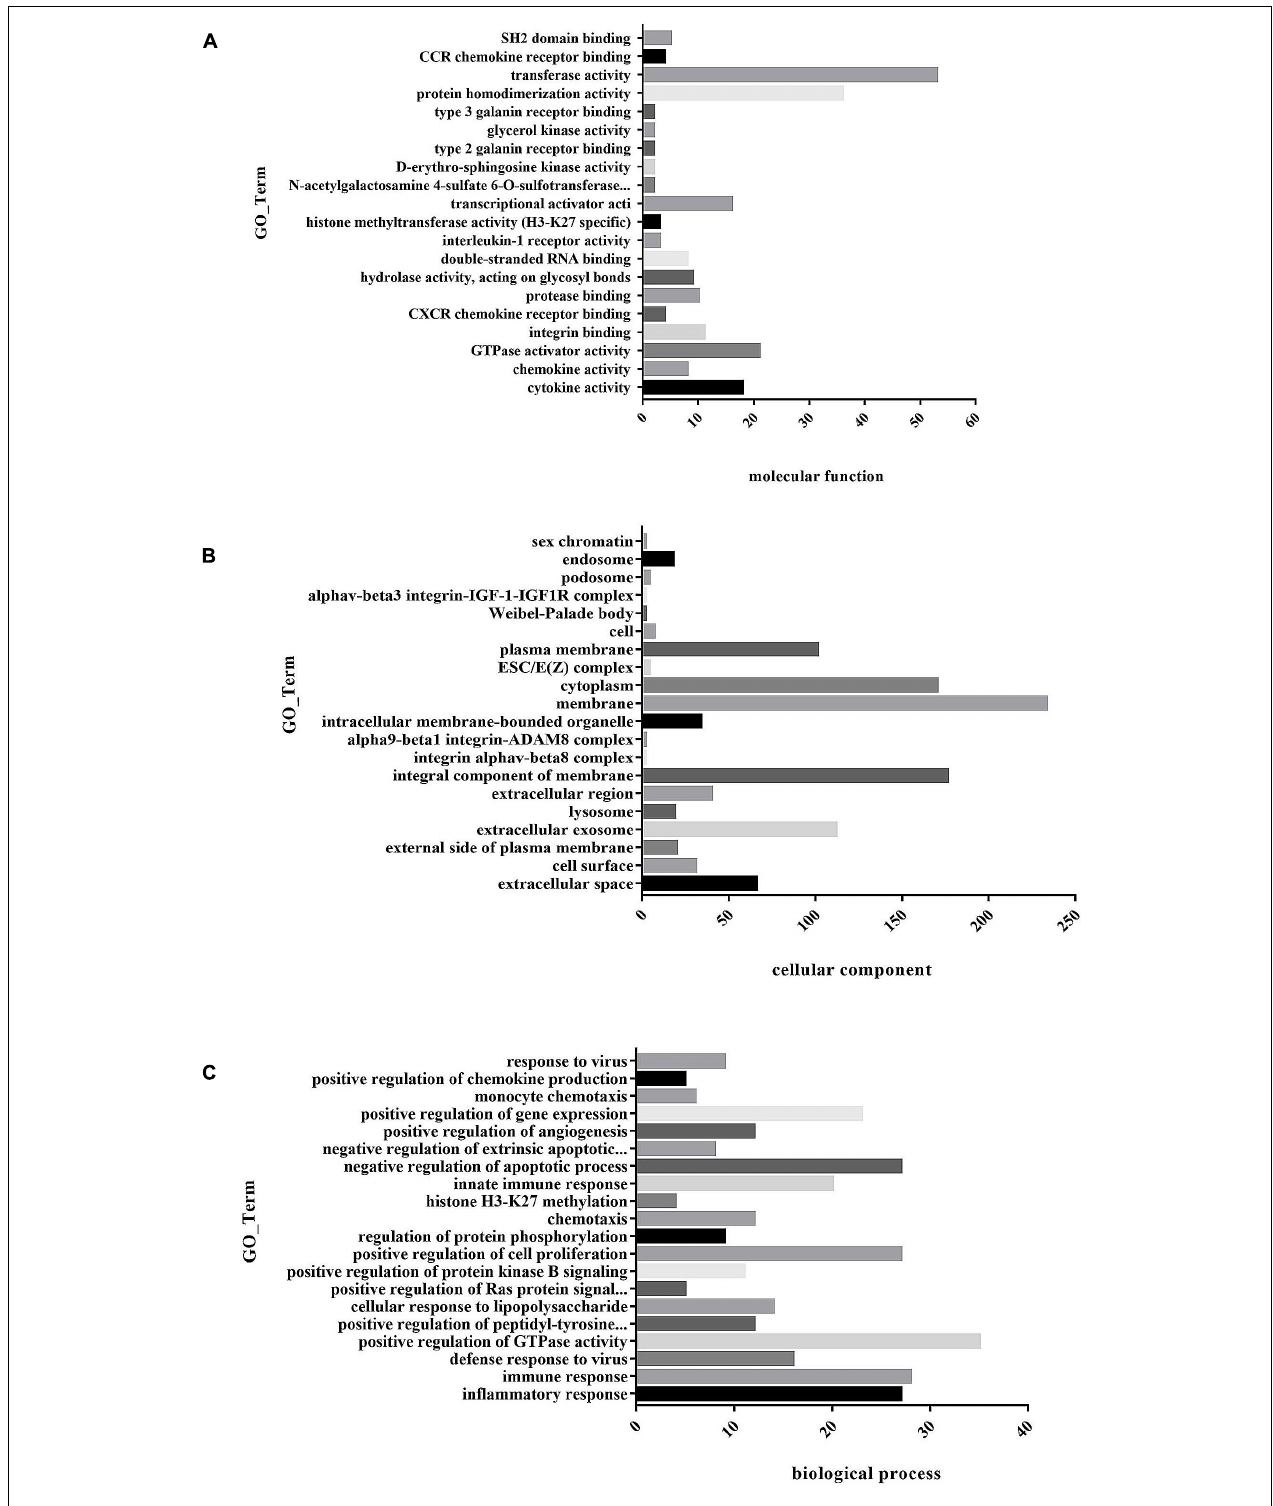
FIGURE 6 | (A) Histogram of GO enrichment of differential genes. The first 20 GO enrichment maps of molecular function. (B) Histogram of GO enrichment of differential genes. The first 20 GO enrichment maps of cell composition. (C) Histogram of GO enrichment of differential genes. The first 20 GO enrichment maps of biological